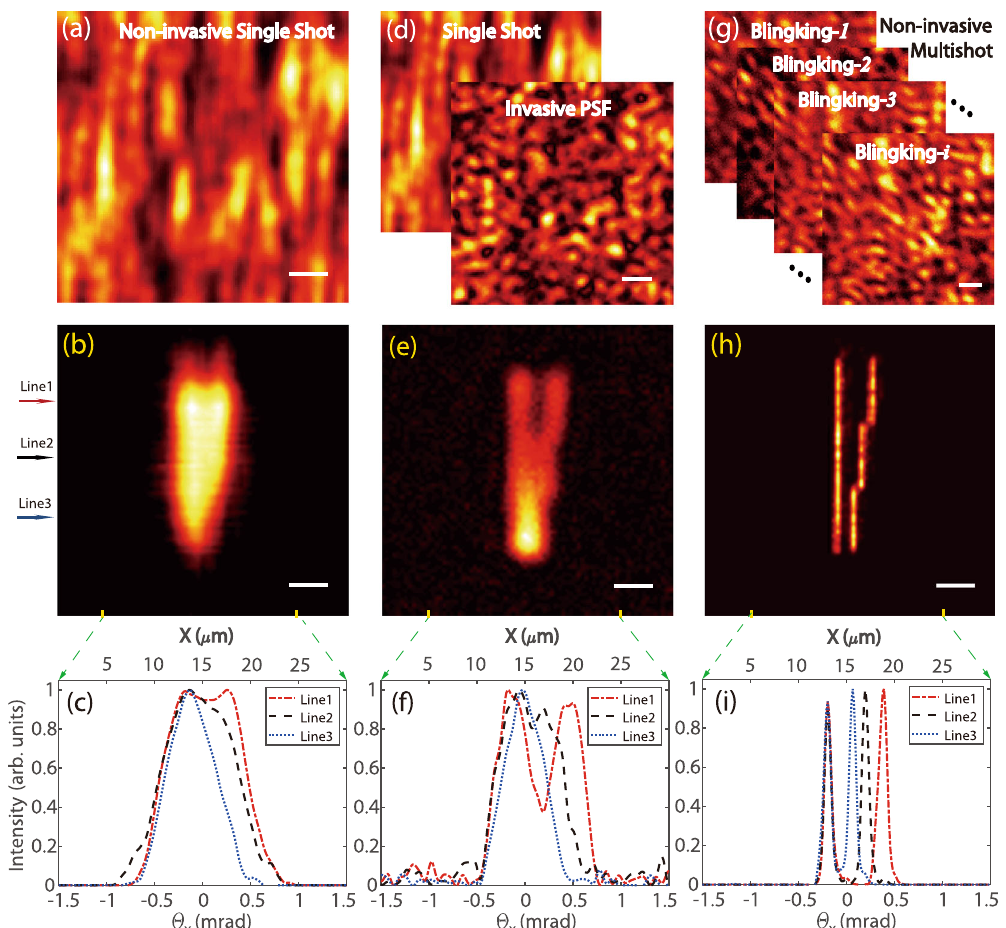
Fig. 3 Experimental results of imaging through a ground glass diffuser with different techniques. a Non-invasive single-shot speckle pattern for phase- retrieval algorithm. b , c Phase-retrieved image and its intensity pro fi le, respectively. d Invasively measured PSF and single-shot speckle pattern for deconvolution imaging. e , f Deconvolution image and its intensity pro fi le, respectively. g Non-invasive speckle patterns from a stochastic sample for SOSLI. h , i Non-invasive super-resolution imaging by our SOSLI and its intensity pro fi le, respectively. Three arrows on the left indicate the three lines for cross- sectional intensity curves in c , f , i . Scale bars: 10 camera pixels, equivalent to 6.5 µ m on the object